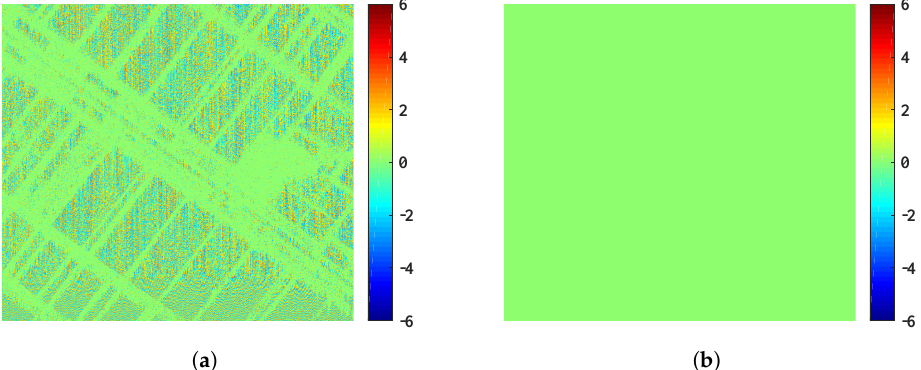
Figure 3. The phase difference between an MF-based image and ( a ) sparse solution ˆX B ; ( b ) non-sparse solution ˜X B